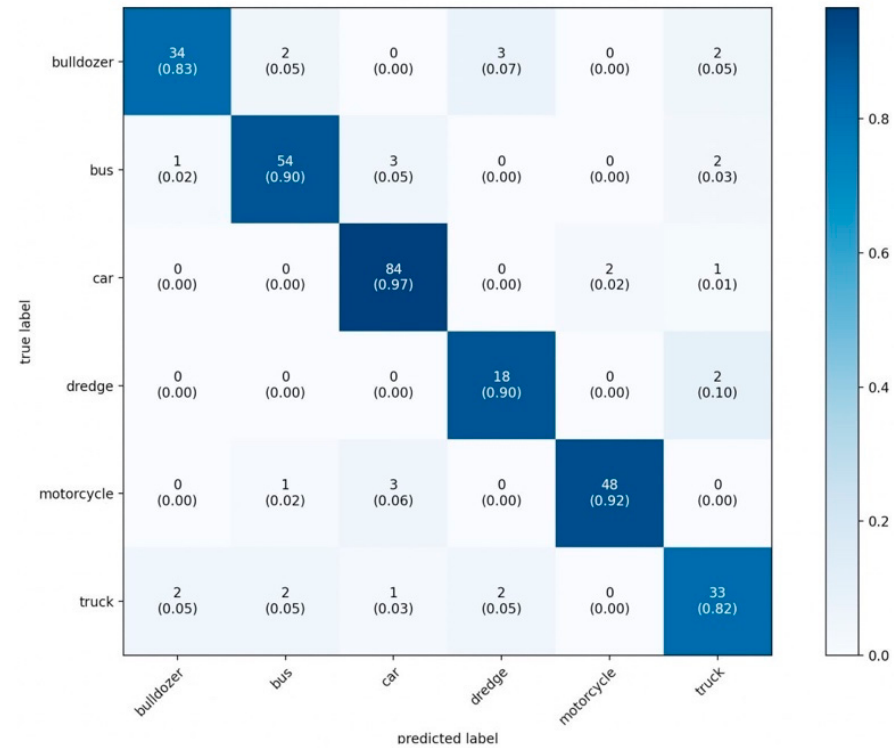
25, 50 and 75 epochs and their visualization is carried out using TensorFlow and is shown